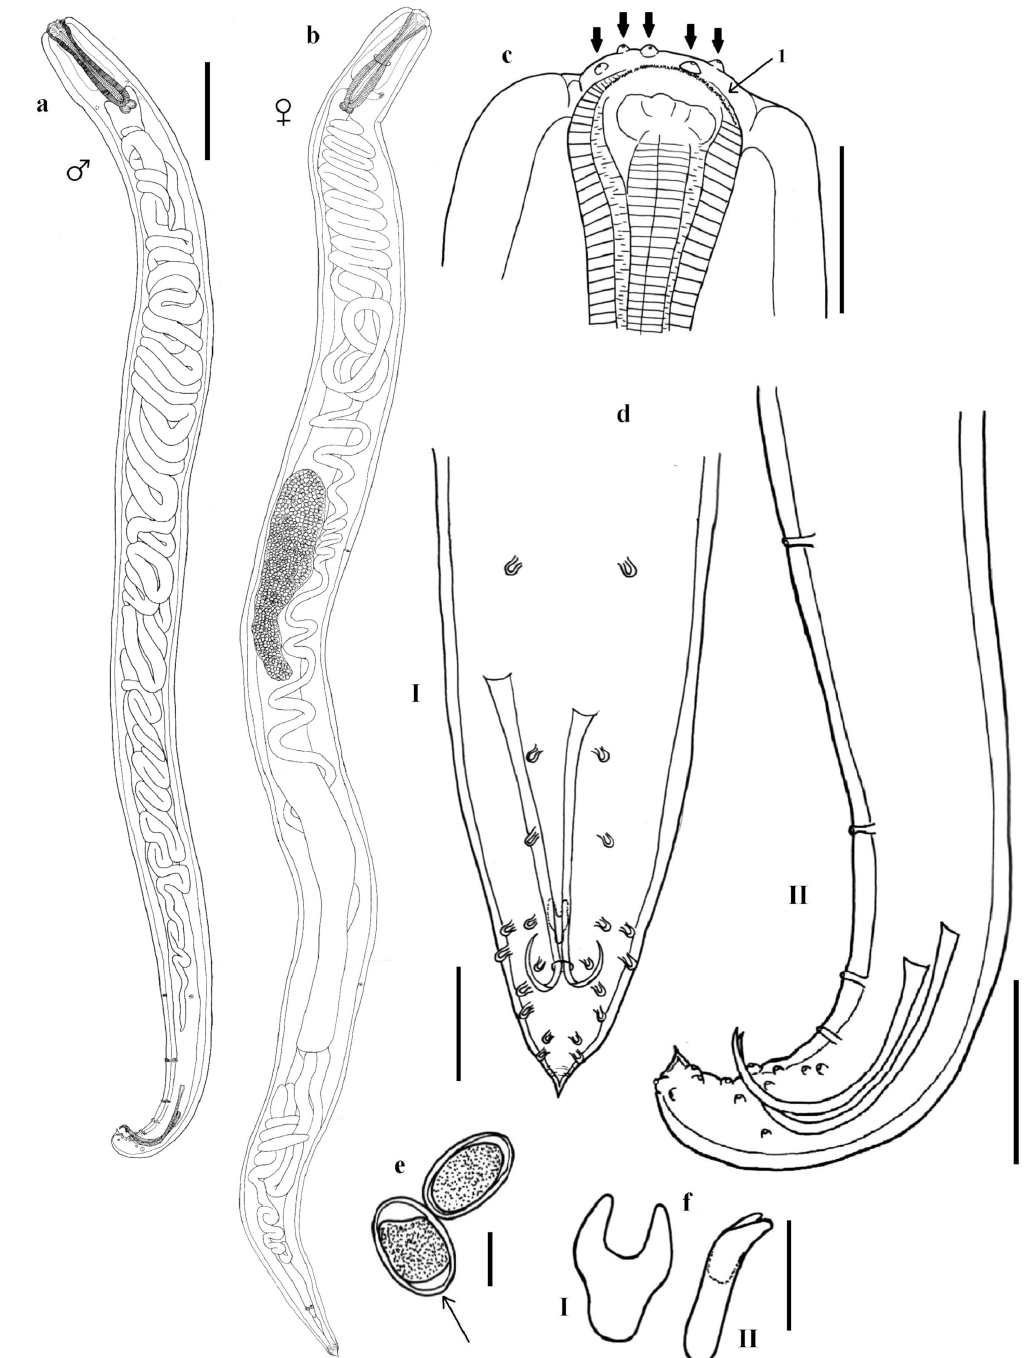
Figure 1 - Dichelyne bonacii collected from lutjanidae of the northeast coast of Brazil. a - Male side view, I- Deirids; II - excretory pore; b - female ventral view, bar: 1mm; I-Nervous ring; II- Opening of the vulva; c - Anterior region, with labial papillae (smaller arrows); I- small serrated teeth of the mouth, bar: 0.5mm; d - I - ventral view of the posterior region of the male, showing the arrangement of the caudal papillae, bar: 0.1mm; II- lateral view of the posterior region of the male, bar: 1mm; eggs, bar: 0.01mm; f- gubernculum, ventral (I) and lateral (II) vision, bar: 0.05 mm; g- Winged spikes of the male, bar: